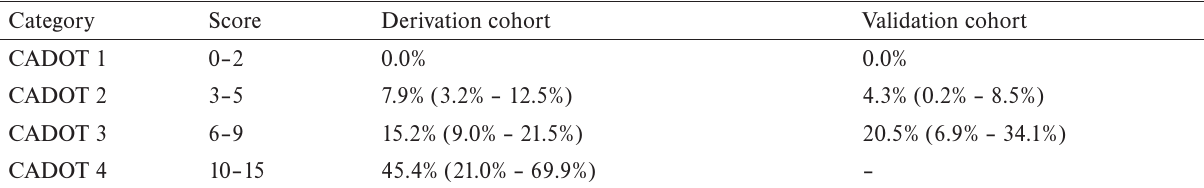
Table 3. Prediction of 2-year mortality (95% CI) according to the CADOT total score.